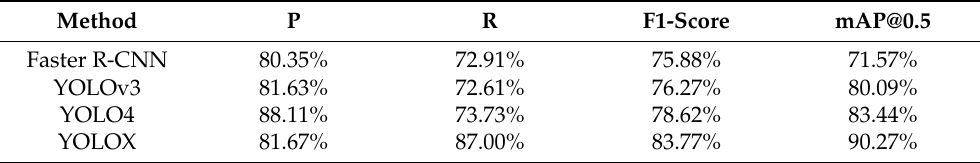
Table 5. Comparison of test results of different models under the test dataset LPD.